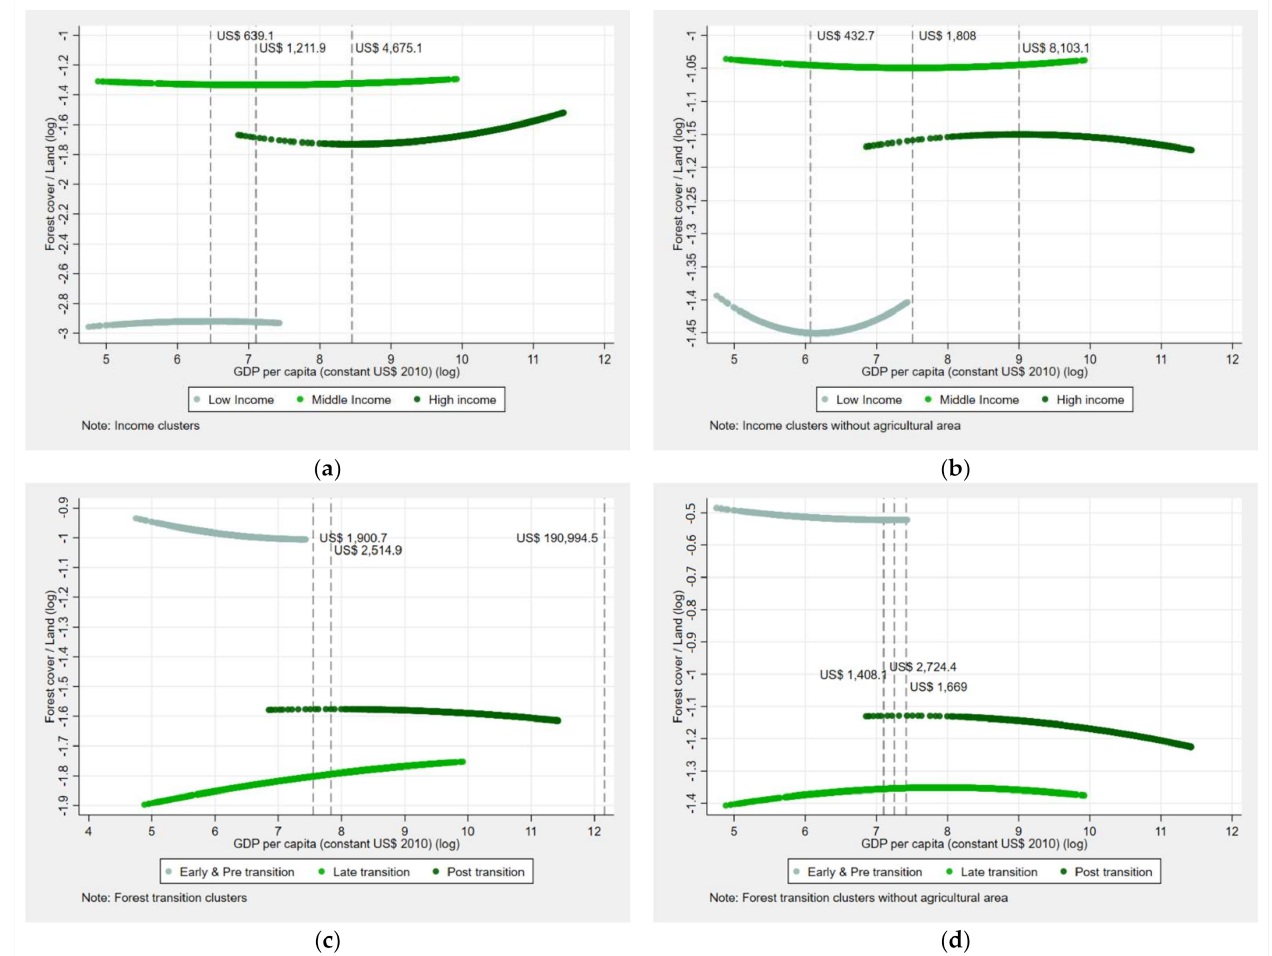
Figure 2. Graphical representation of the long-run results (four our sample). Note: Figure ( a ) shows the result for the long-run equation for income groups in Table 4 columns 1, 3, and 5. The turning points are the following: US$639.1 for low income, US$1211.9 for middle income, and US$4675.1 for high income. Figure ( b ) shows the result for the long-run equation in Table 4 columns 2, 4, and 6 (model without agricultural area). The turning points are the following: US$432.7 for low income, US$1808 for middle income, and US$8103.1 for high income. Figure ( c ) shows the results for the long-run equation for the forest transition phases classification, in Table 6, columns 1, 3, and 5. The turning points are the following: US$1900.7 for early and pre-transition, US$190,994.5 for late-transition, and US$2514.9 for post-transition. Figure ( d ) shows the result for the long-run equation in Table 6, columns 2, 4, and 6 (model without agricultural area). The turning points are the following: US$1408.1 for early and pre-transition, US$2724.4 for late-transition, and US$1669 for